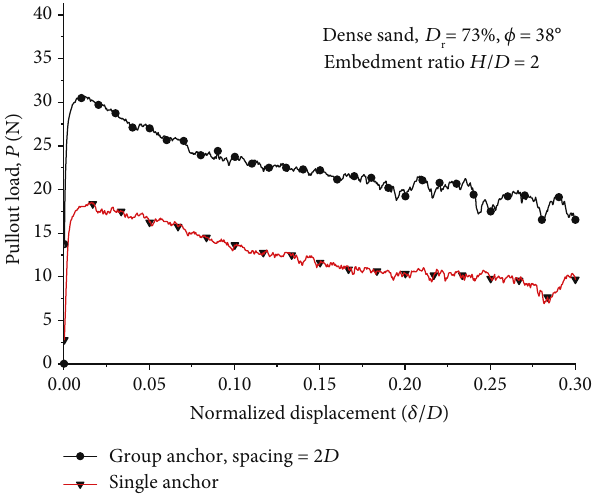
Figure 4: Pullout load – displacement curves for group anchors with H / D = 6 in loose sand.